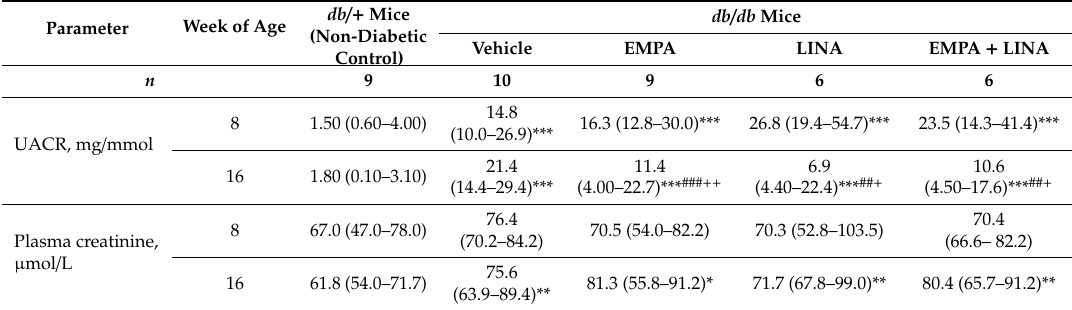
Table 3. Albuminuria and plasma creatinine in db /+ and db / db mice. db /+ Mice Parameter Week of Age